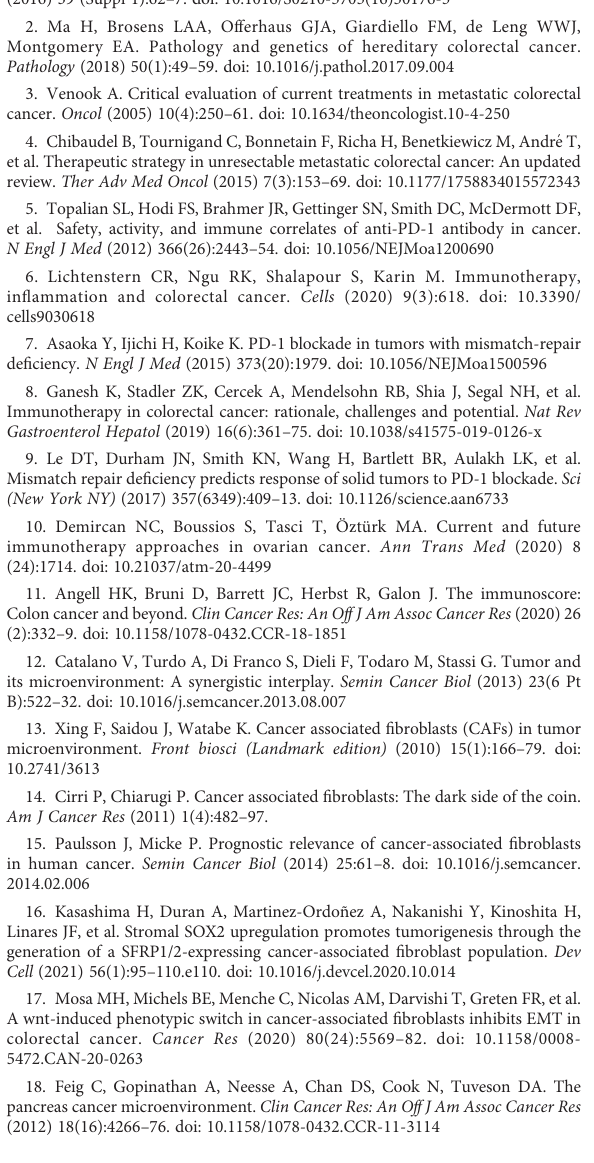
SUPPLEMENTARY FIGURE 2 (A) Distribution of subpopulations of all cells after cluster analysis; (B) t- SNE map of marker gene expression in fi broblasts; (C) Distribution of fi broblast subgroups after re-clustering; (D) t-SNE map of marker gene expression in four small fi broblast